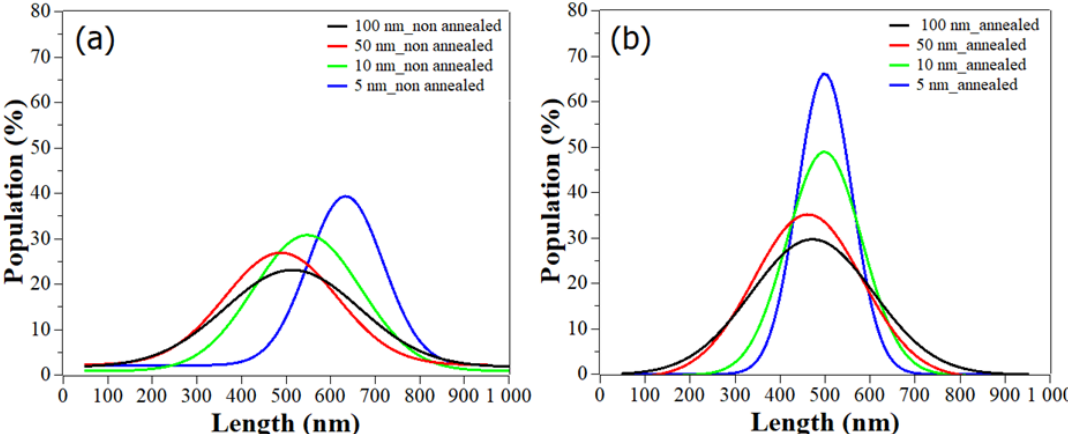
Figure 5. Gaussian fit for the distribution of ZnO NWs length as function of ( a ) non-annealed and ( b ) annealed ZnO seed layers with different thicknesses.